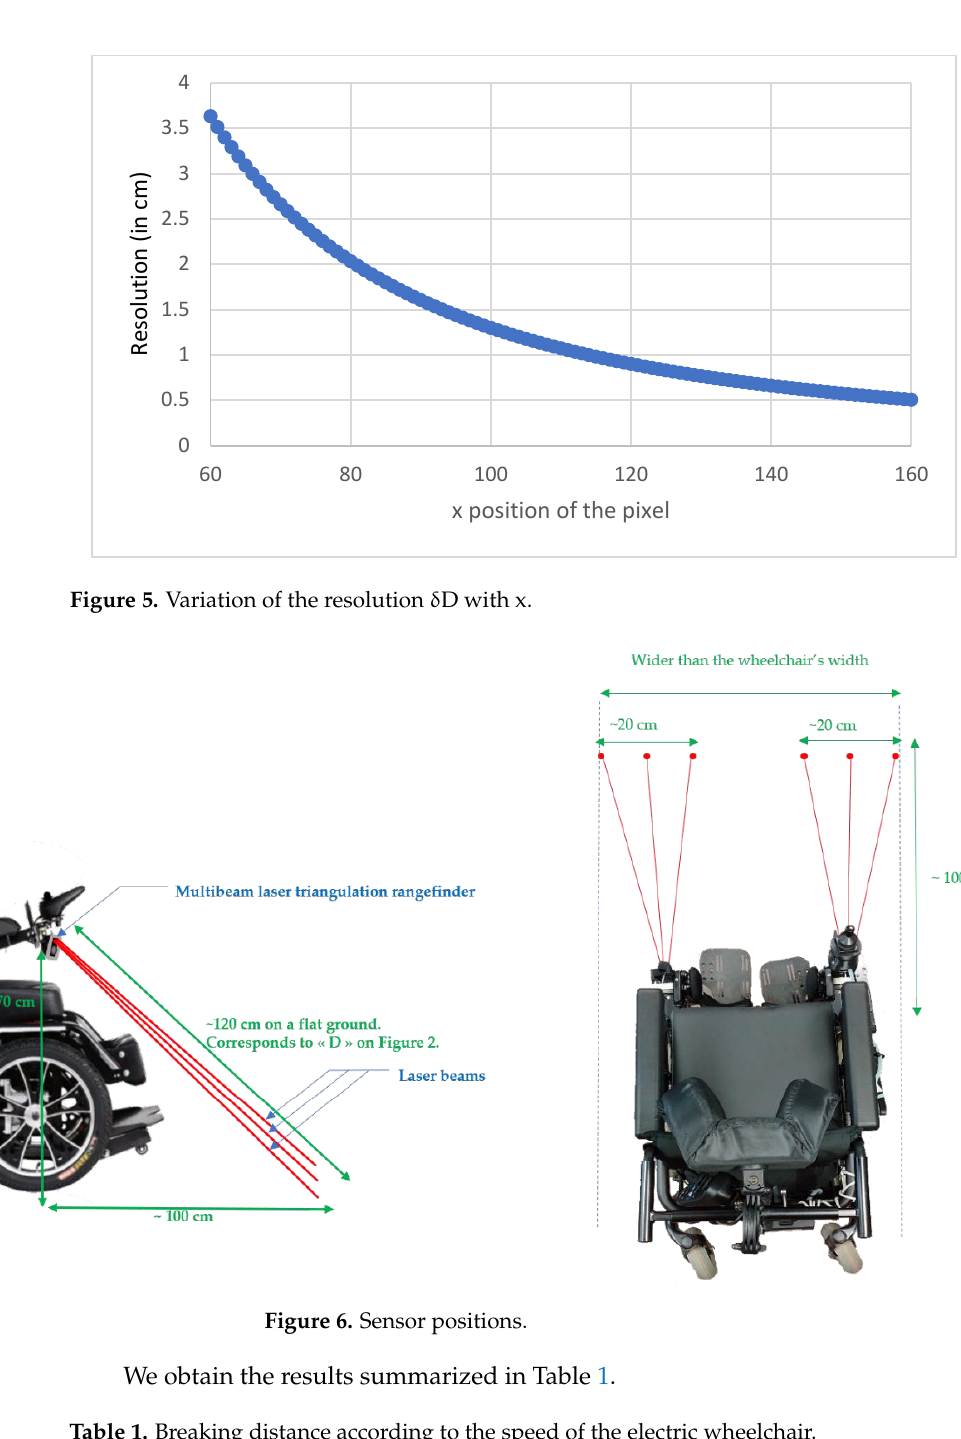
7 of 20 Figure 4. Variation of D with x for the central beam.